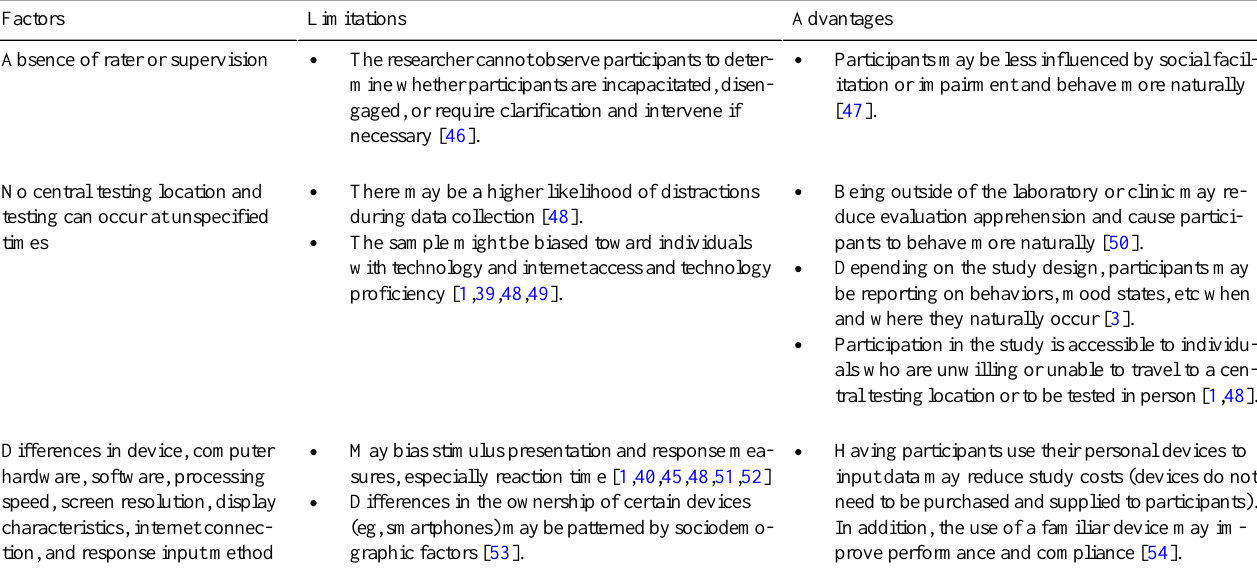
Table 1. Key factors to consider when validating assessments for remote